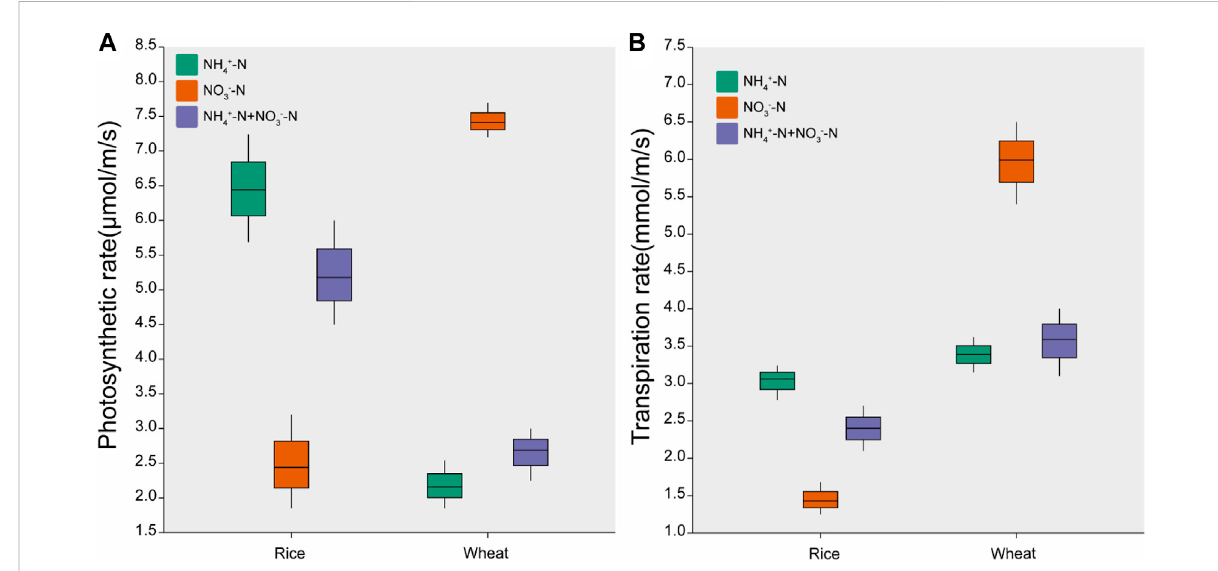
FIGURE 2 Effects of different nitrogen forms on (A) photosynthesis rate and (B) transpiration rate. Data are means ± standard error of four replicates ( n =